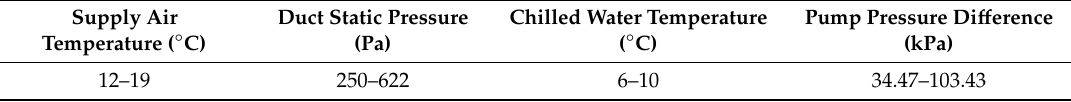
Table 2. Control ranges for calculation of the genetic algorithm.